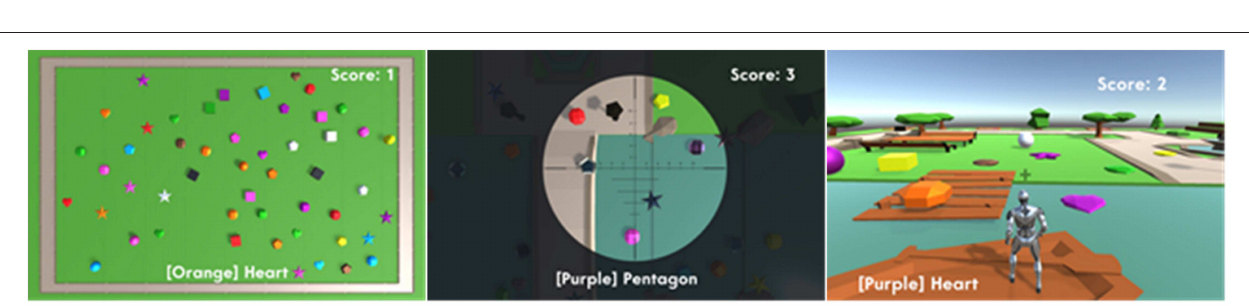
The games are not only differentiated by style and